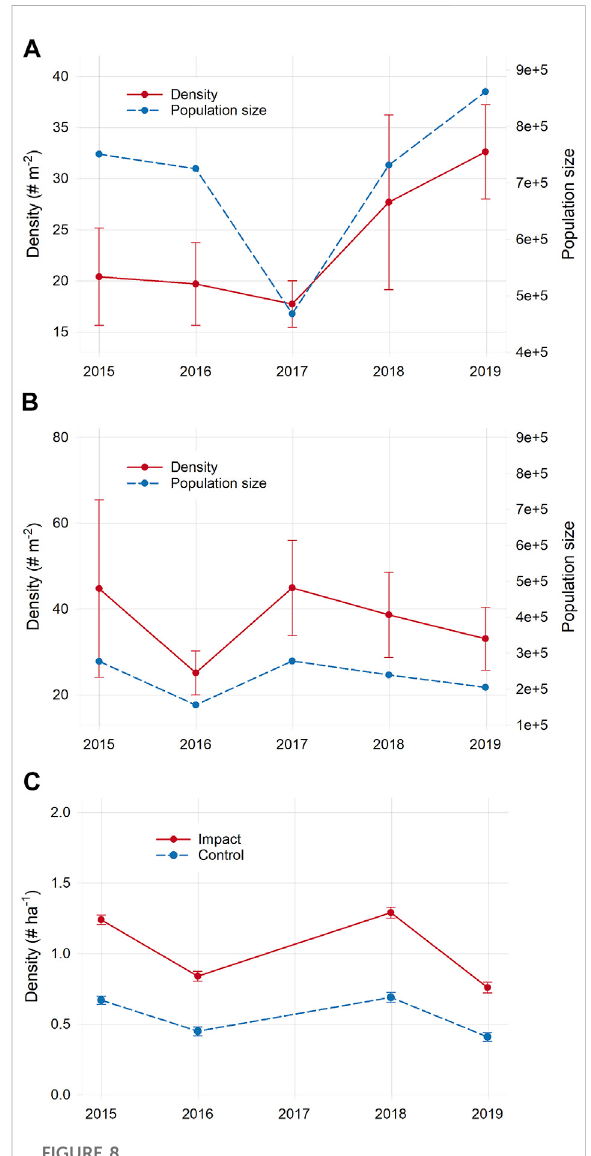
FIGURE 8 Changes in total nekton density and total nekton population sizeintheimpact (A) andcontrol (B) marshes,andtotalbirddensity (C) over time. Sediment placement occurred between 2016 and 2017 at the impact site. Error bars for density are 1 SE. Population size for each marsh × year was calculated by multiplying total density by the total area (in square meters) of all shallow aquatic habitat available to nekton in each